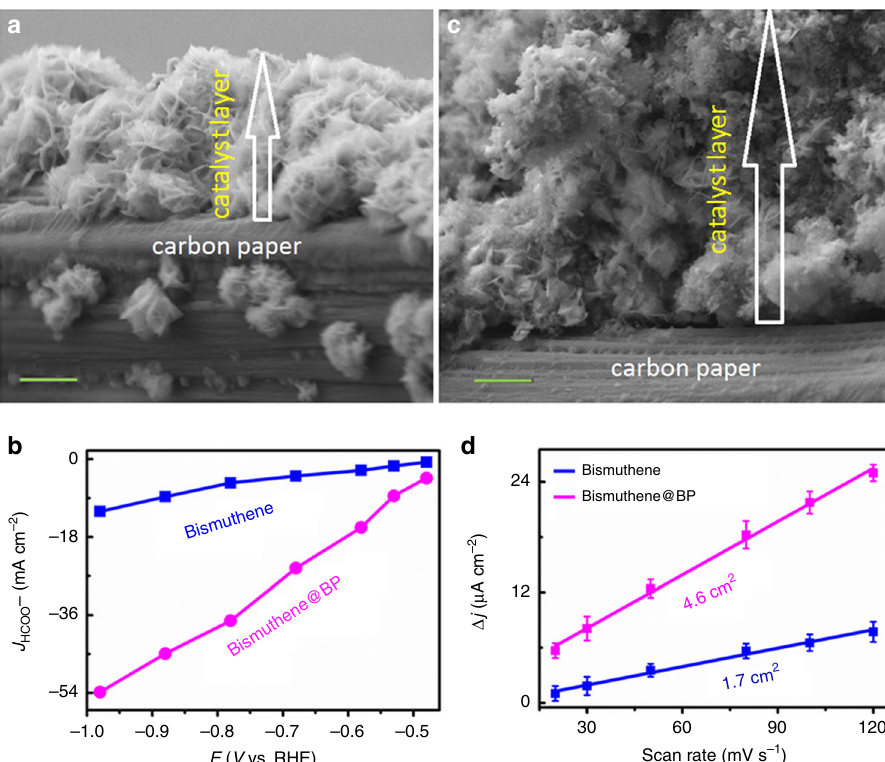
Fig. 4 BP-induced enhancement of CO2RR performance on Bismuthene. a SEM image of the transect to show the compact catalyst layer of Bismuthene nanosheets on carbon paper electrode. b Partial current density for HCOO − ( j HCOO- ) versus potential on Bismuthene and Bismuthene@BP (with BP 3 wt.% optimally). c SEM image of the transect to show the noncompact catalyst layer of Bismuthene@BP on carbon paper electrode. The arrows in ( a , c ) indicate the thickness difference of the catalyst layers with the same mass loading, scale bars in ( a , c ): 1.0 μ m. d ECSA measurement for both pure Bismuthene and Bismuthene@BP. All the error bars in ( d ) represent the standard error of the mean.